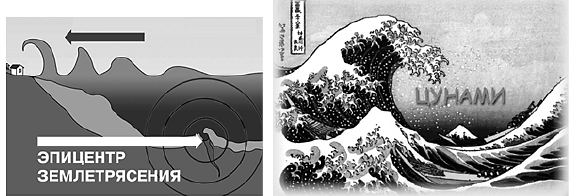
Fig. 9 . The scheme of tsunami formation is on the left. Picture of a Japanese artist with an illustration of the tsunami-on the